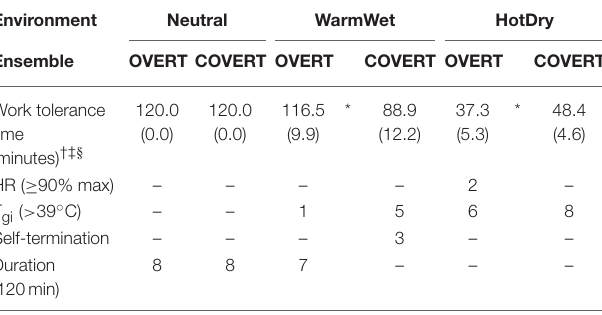
TABLE 3 | Mean (SD) work tolerance times and the number of participants meeting each termination criteria within each environment and ensemble. Environment Neutral WarmWet HotDry OVERT COVERT OVERT COVERT OVERT